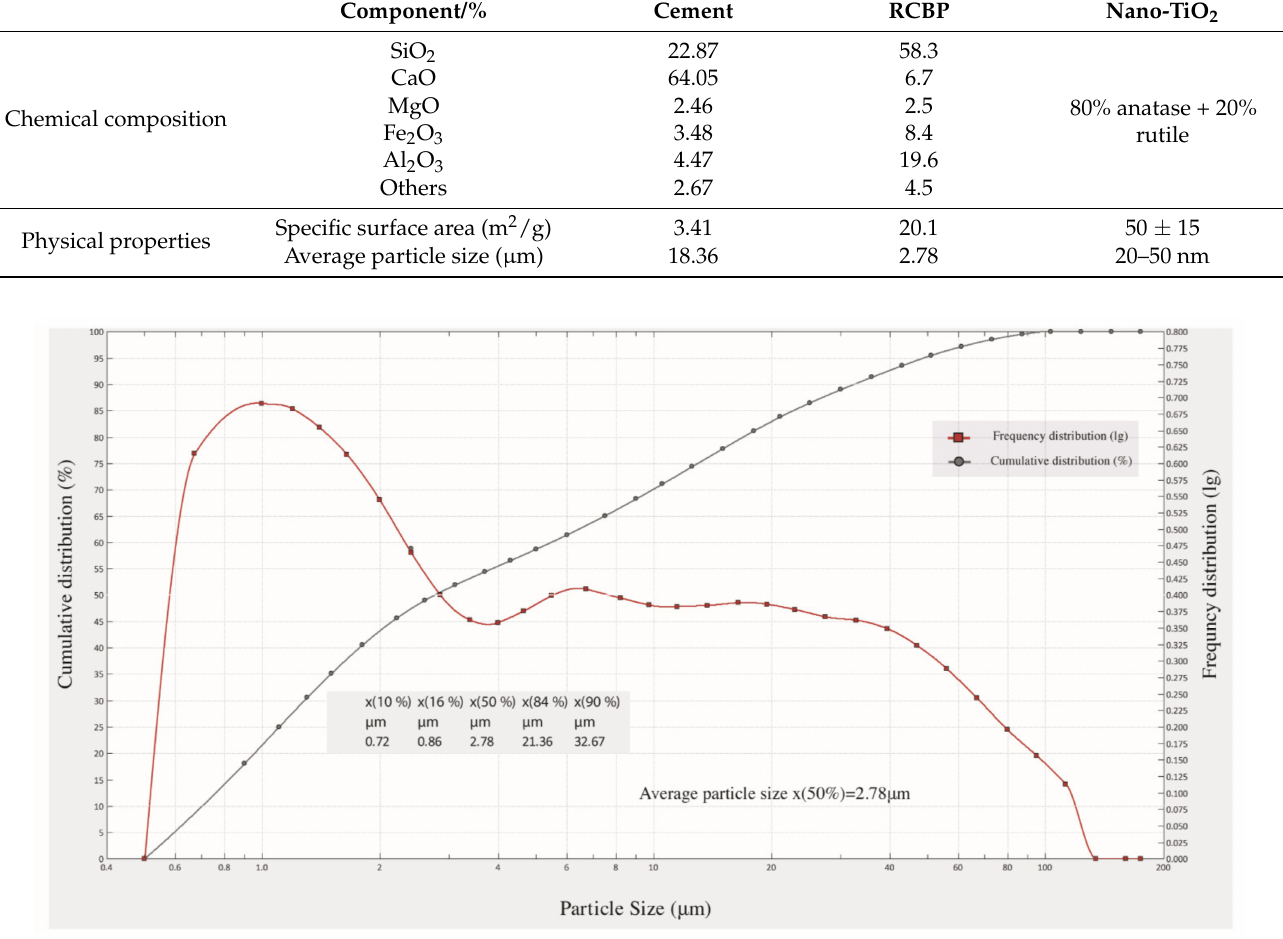
Figure 1. Particle size distribution of recycled clay brick